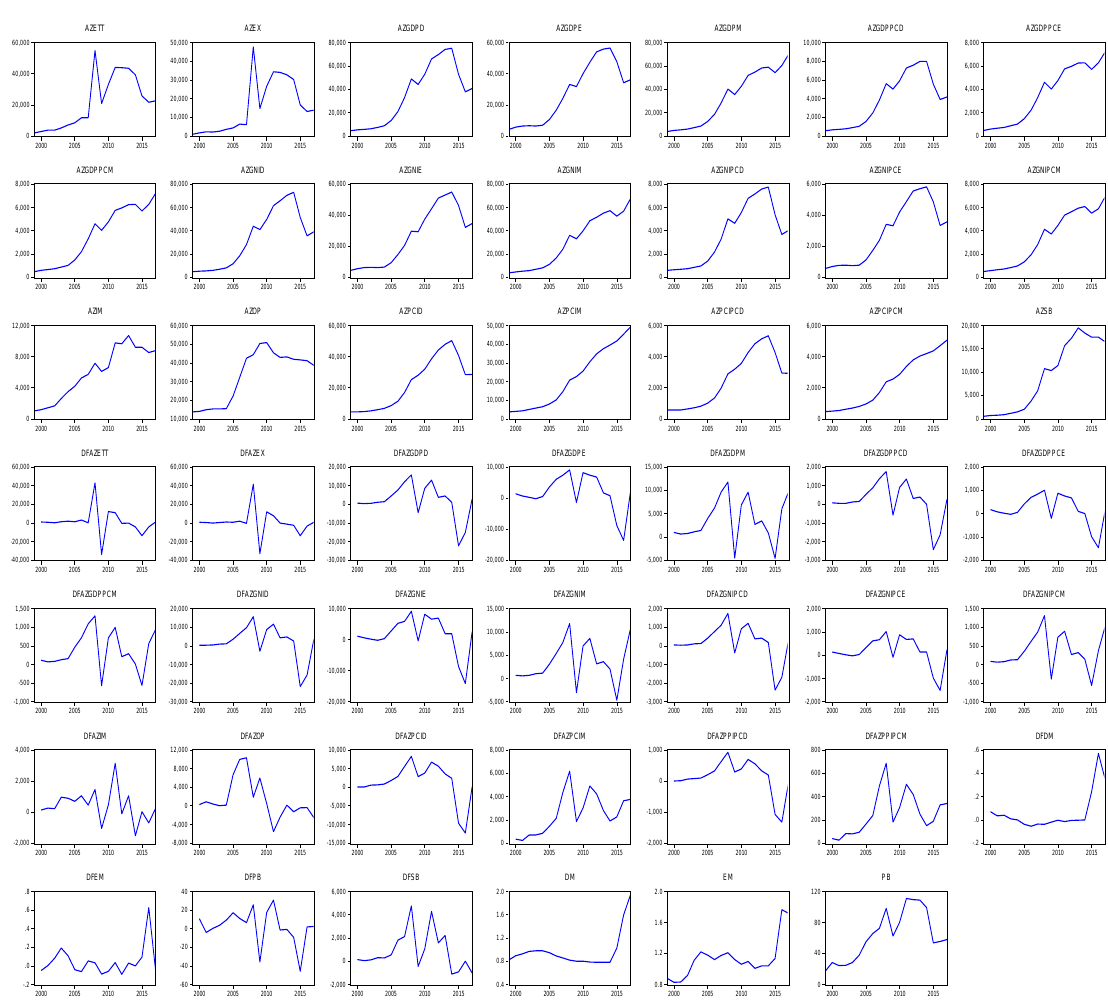
Figure A3. Azerbaijan GDP, investment on fixed capital, oil production, oil price. Energies 2019 , 12 , x FOR PEER REVIEW 36 of 40